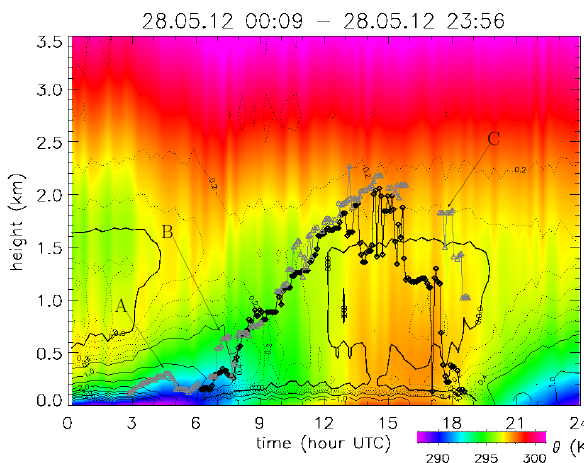
Figure 5. Time–height section of potential temperature from HAT- PRO (colour shading). Black line with diamonds shows ML from wind, grey line with triangle ML from aerosol. Solid isolines show the vertical potential temperature gradient in steps of 0.5K/100m (solid), dotted lines in steps of 0.1K/100m between − 0.9K/100m to + 0.9K/100m. The thick isoline marks neutral stratification (0K/100m). Letters A, B and C refer to descriptions in the